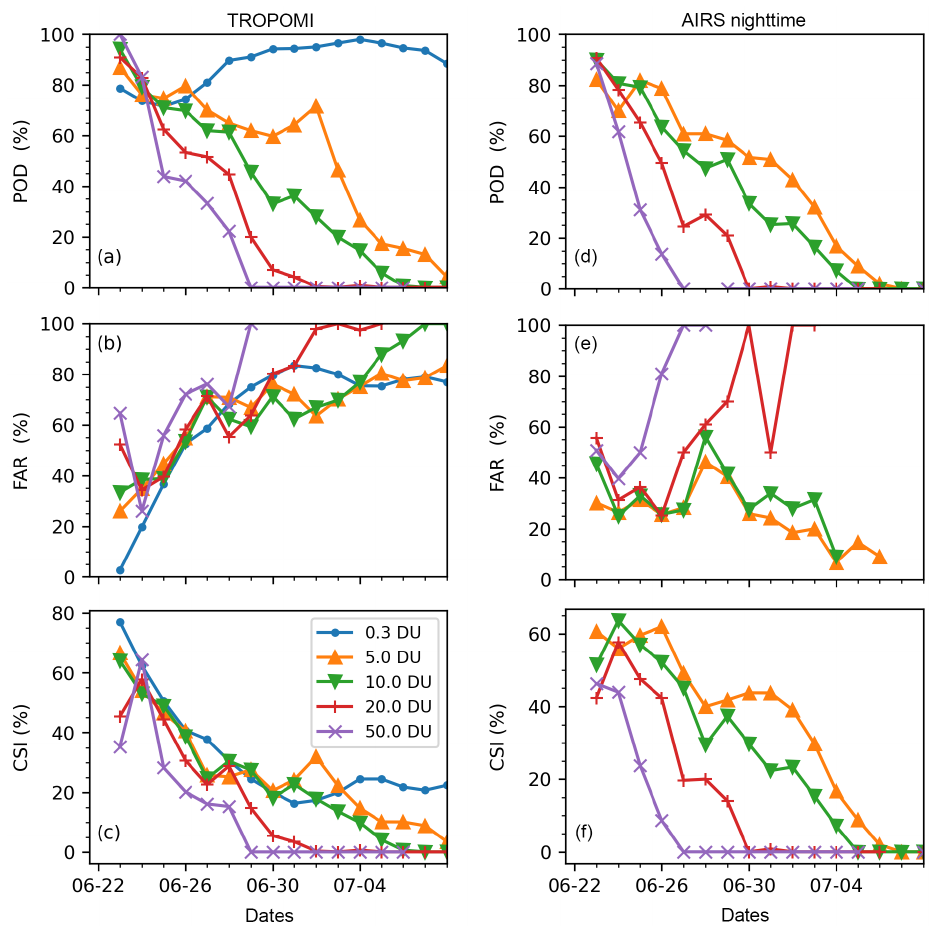
Figure 13. Left panels (a–c) : time series of the probability of detection (POD; a ), false alarm rate (FAR; b ), and critical success index (CSI; c ) for a forward simulation initialized by the reconstructed injection parameter based on TROPOMI data. The TROPOMI retrievals are used as reference observations. Subplots in the right panels (d–f) are the same as the left panels but for AIRS nighttime data, and the reference observations are also from the AIRS nighttime data. Color coding indicates the column density threshold used to detect events (see plot